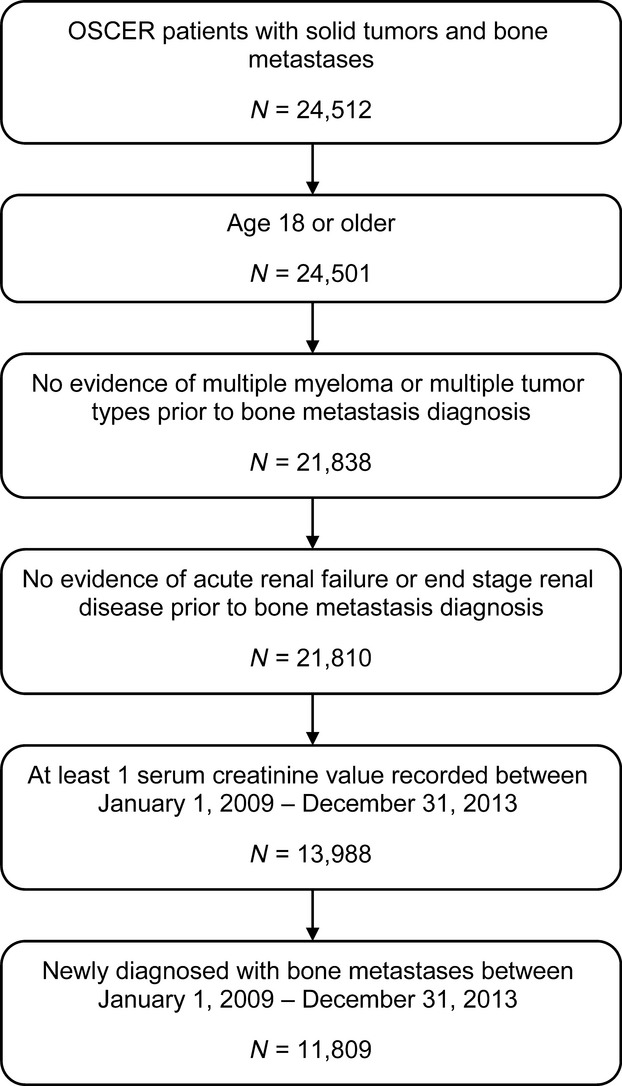
Patient selection.